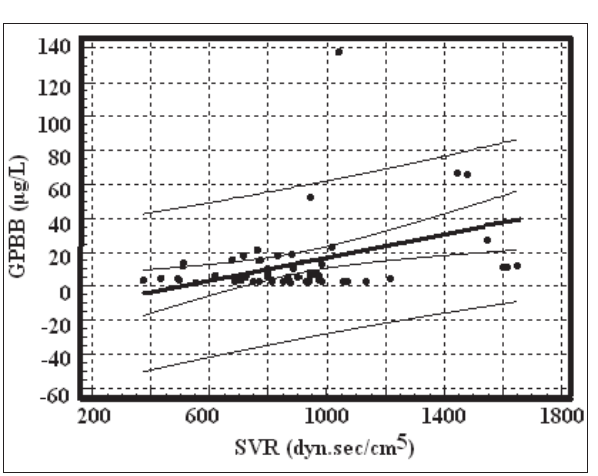
Fig. 2. Association of serum GPBB measured 24 h after TIPS with cardiac index (CI) before